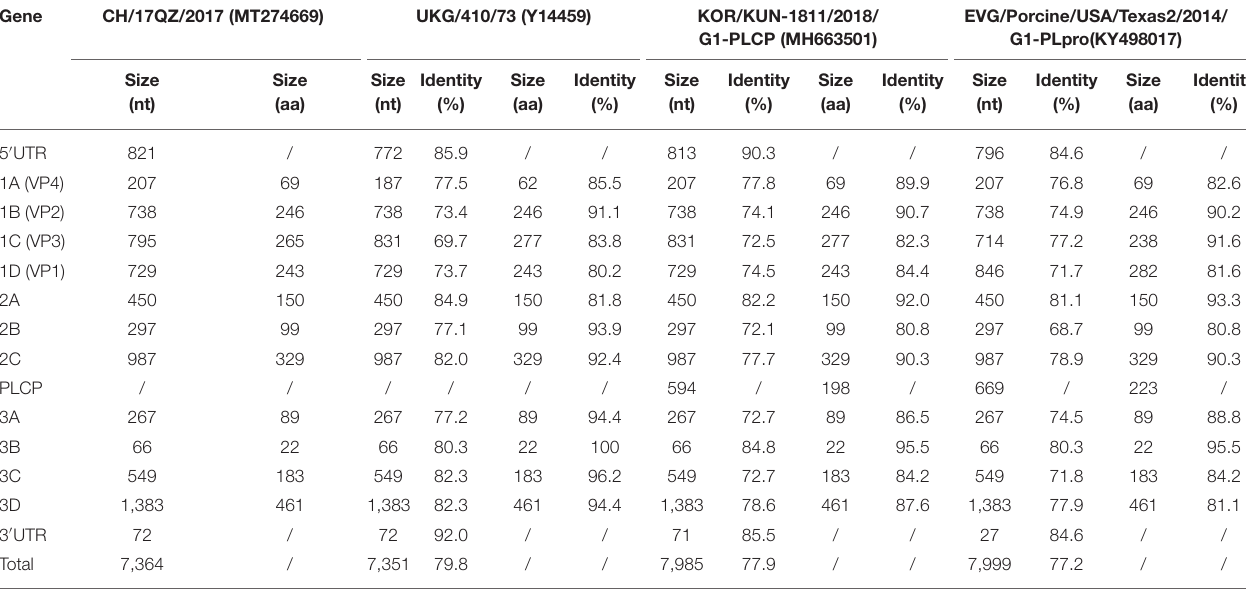
TABLE 2 | Nucleotide and amino acid identities of CH/17GXQZ/2017 when compared with EV-G reference strains.